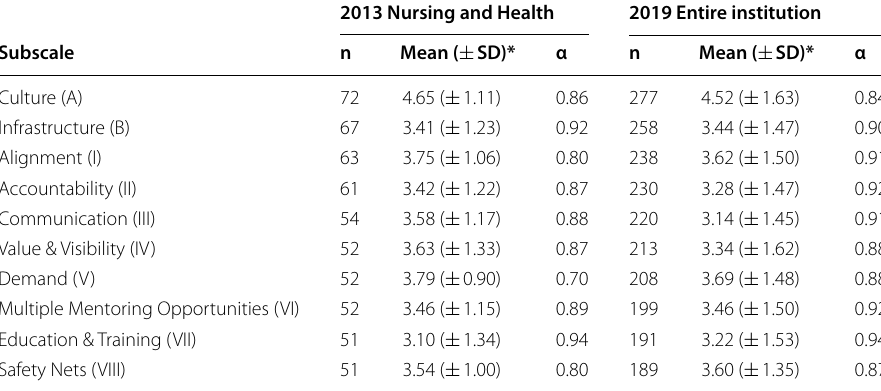
*Measured on a 7-point scale (strongly disagree, disagree, somewhat disagree, neither-disagree-nor-agree, somewhat agree, agree, strongly agree) with higher scores indicating higher levels of the measured subscale